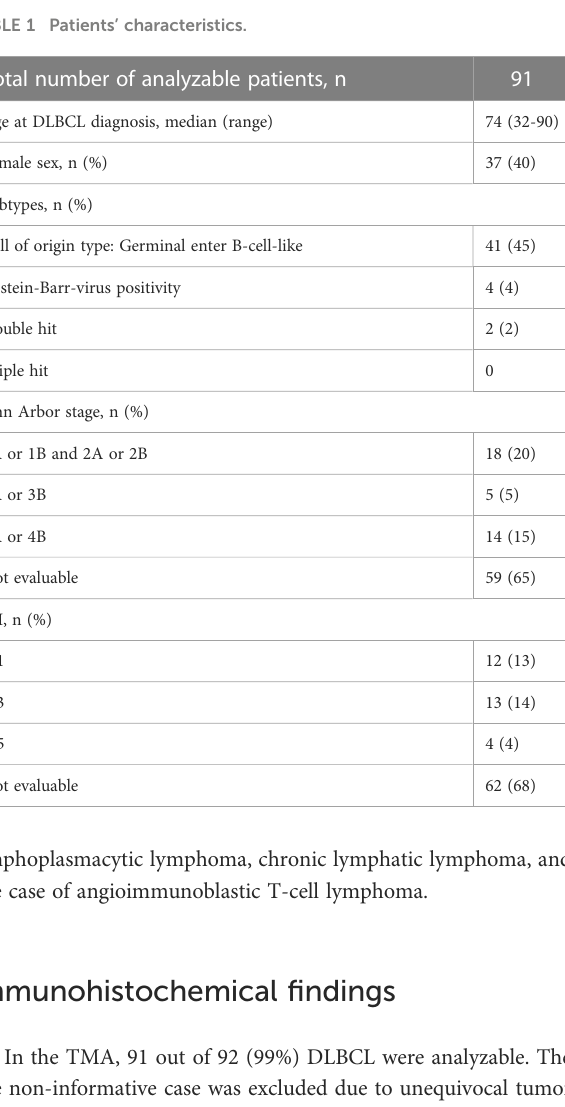
TABLE 1 Patients ’